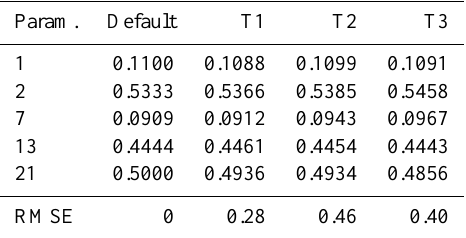
Table 4. Default and optimized parameter values of optimization trials T1, T2, and T3 for the five-dimensional pseudo data case. We report four decimal places because the model output is sensitive to very small changes for some variables. Note that we scaled the numbers to the interval [0,1].